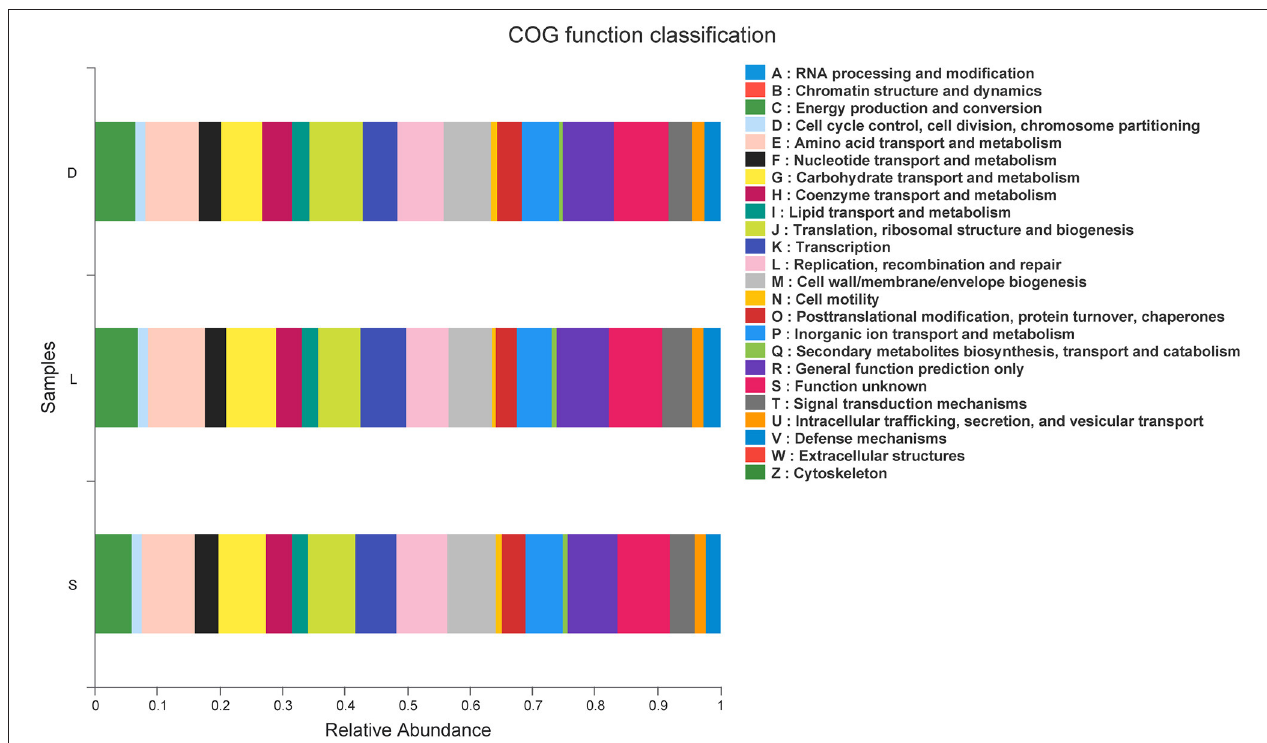
FIGURE 8 | PICRUSt functional prediction was performed using EggNOG database, and pathways related to dog gastrointestinal diseases were